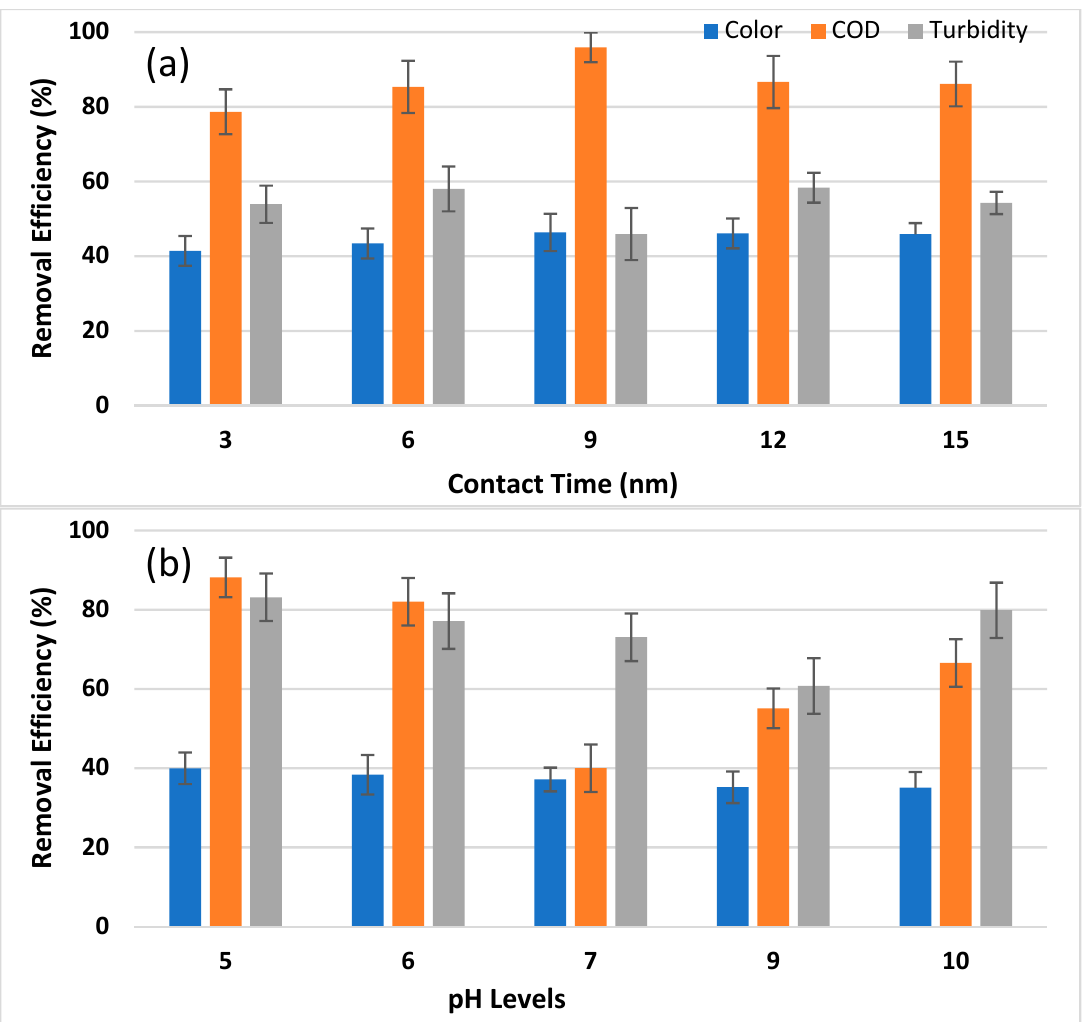
Figure 4. ( a ) Ozone treatment of biologically treated wastewater and removal efficiencies (%) for color, COD and turbidity at varying contact times of 3, 6, 9, 12 and 15 min. ( b ) Ozone treatment of biologically treated wastewater and removal efficiencies (%) for color, COD and turbidity at varying pH values (5, 6, 7, 9 and 10). Means values are presented in graphs with standard deviation. Turbidity removal from wastewater was also studied after the ozone